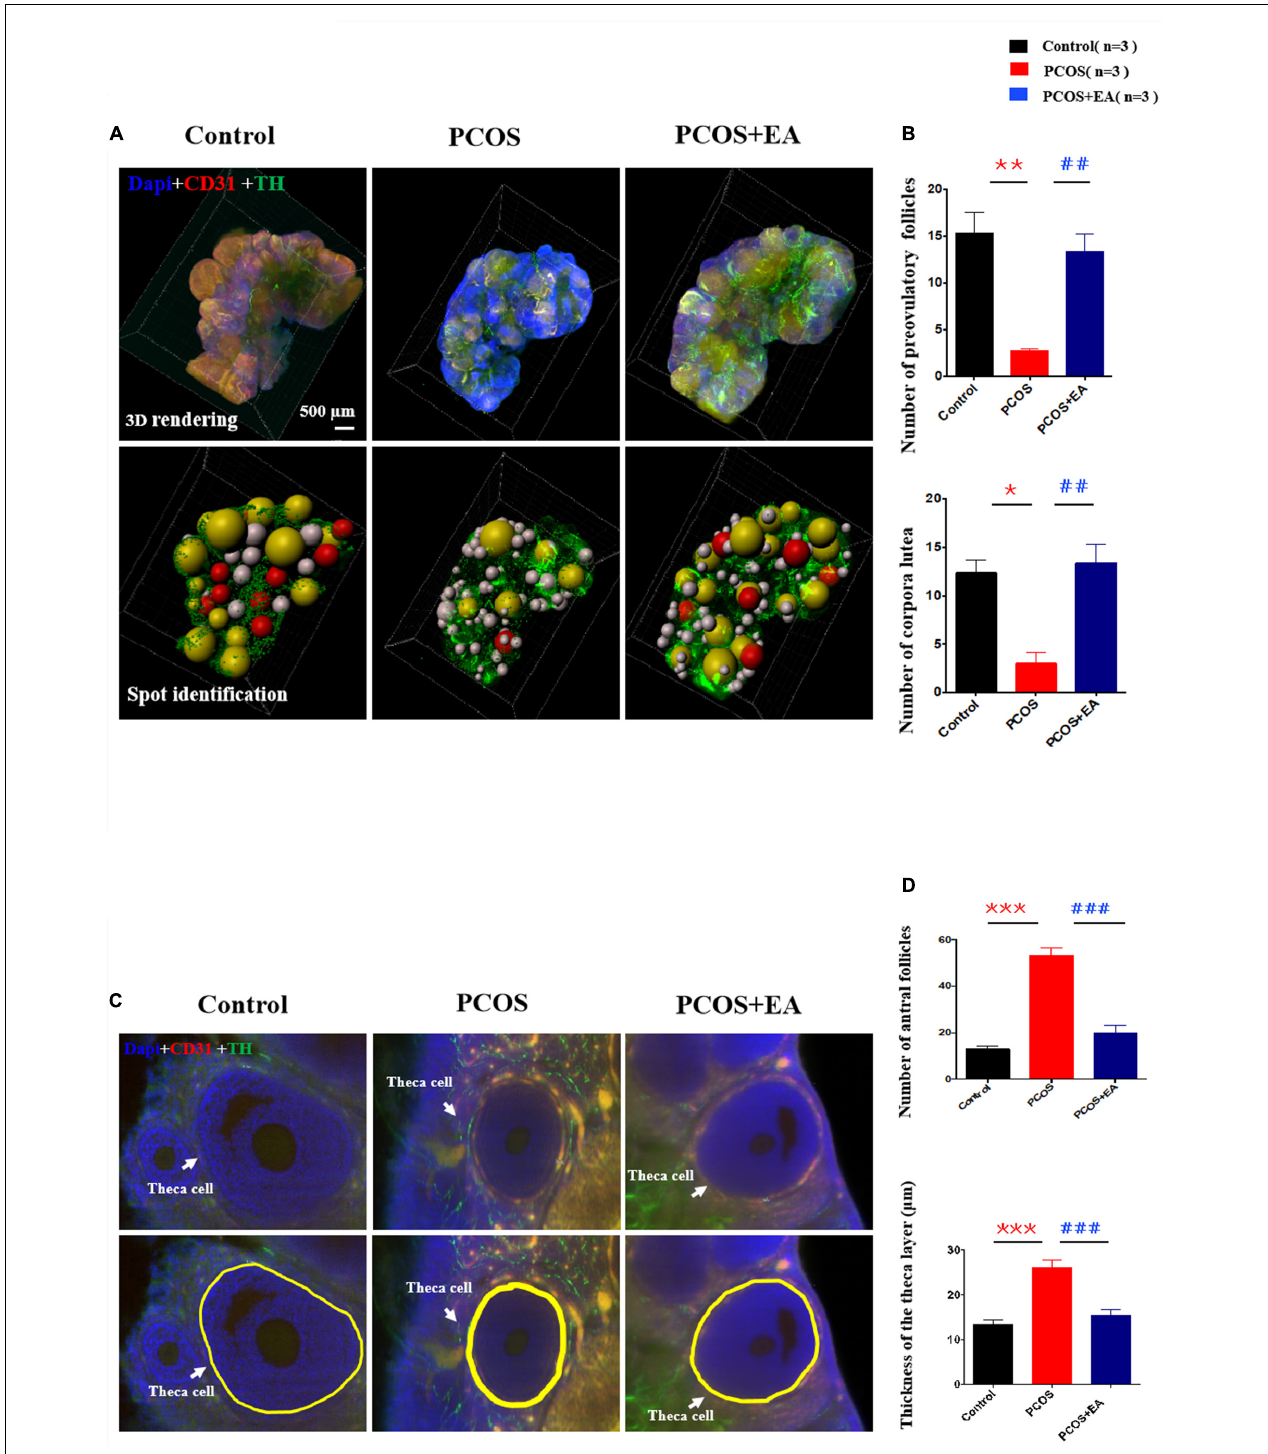
FIGURE 3 | DHT-induced PCOS-like rats showed decreased the number of mature follicles and increased the thickness of the theca cell layer, and the effect of EA treatment. (A) Follicles were stained using DAPI (blue) together with antibodies against CD31 (red) or TH (green) for the identification of ovarian innervation and vasculature, respectively. (B) The numbers of preovulatory follicles and corpora lutea in the three groups. (C) Theca cell layers were increased by DHT and reversed by EA. The thickness of the theca cell layer was measured in 3D images using Imaris (upper panels) from randomly selected antral follicles ( n = 10). (D) The number of antral follicles and the thickness of the theca cell layer around antral follicles were measured in the three groups. * p < 0.05, ** p < 0.01, *** p < 0.001 vs. Control; ## p < 0.01, ### p < 0.001 vs. PCOS.